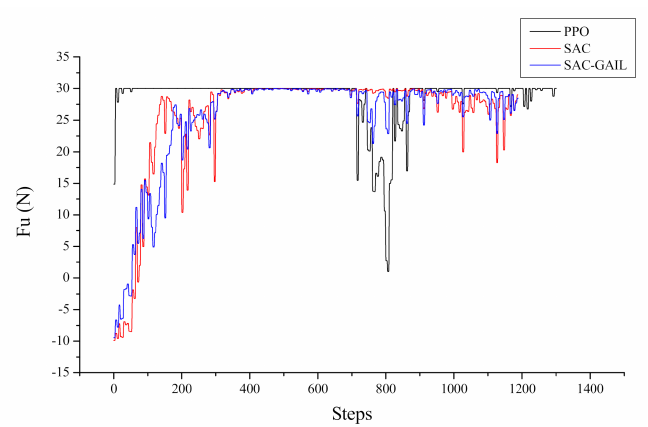
Figure 15. Curve of surge